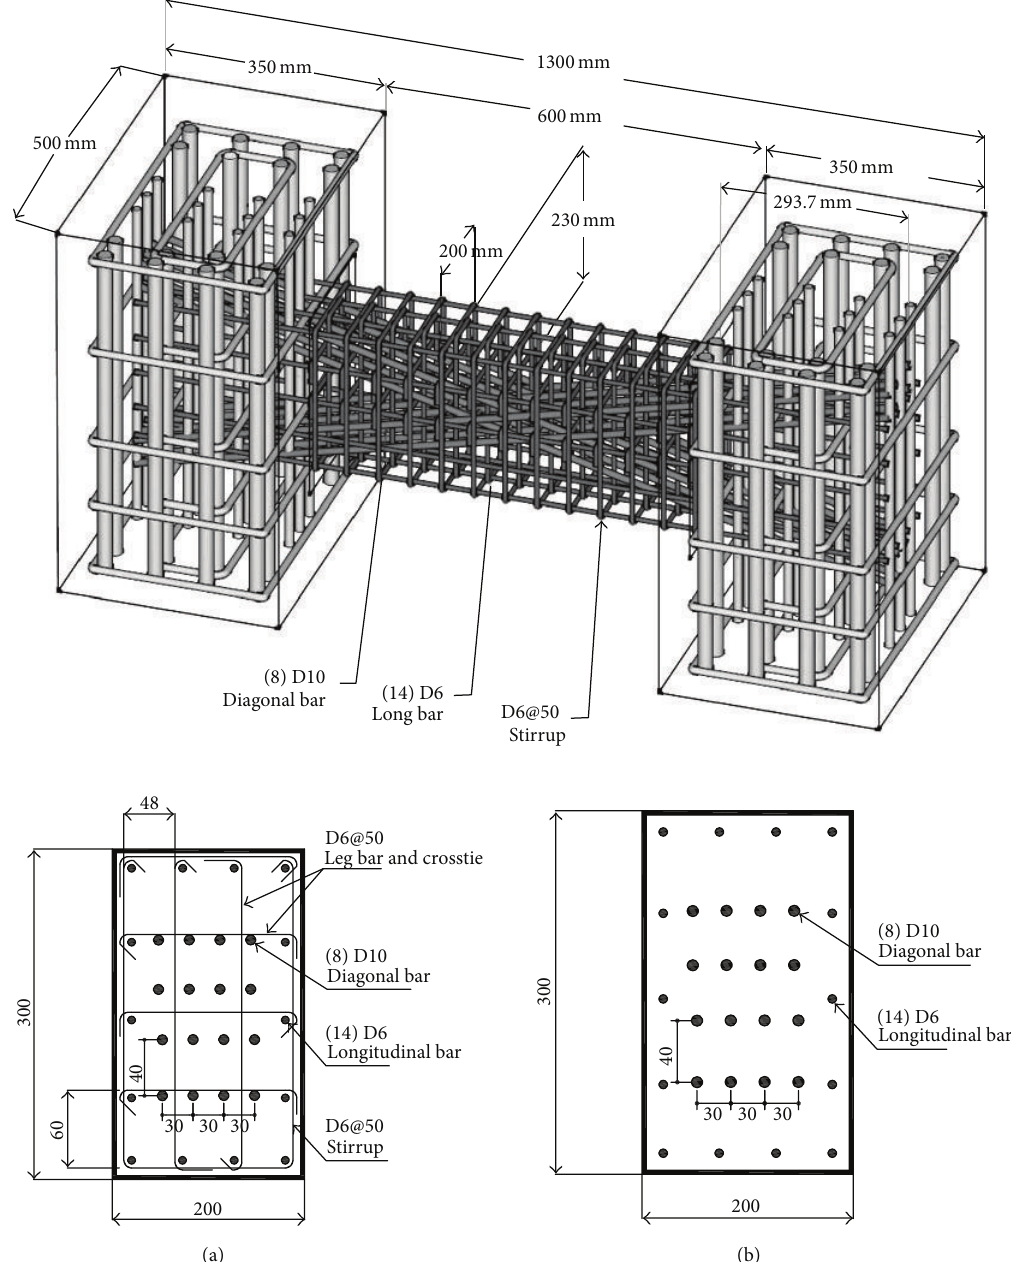
Figure 4: Details of diagonally reinforced coupling beams. (a) CCB specimen. (b) SFRCCB